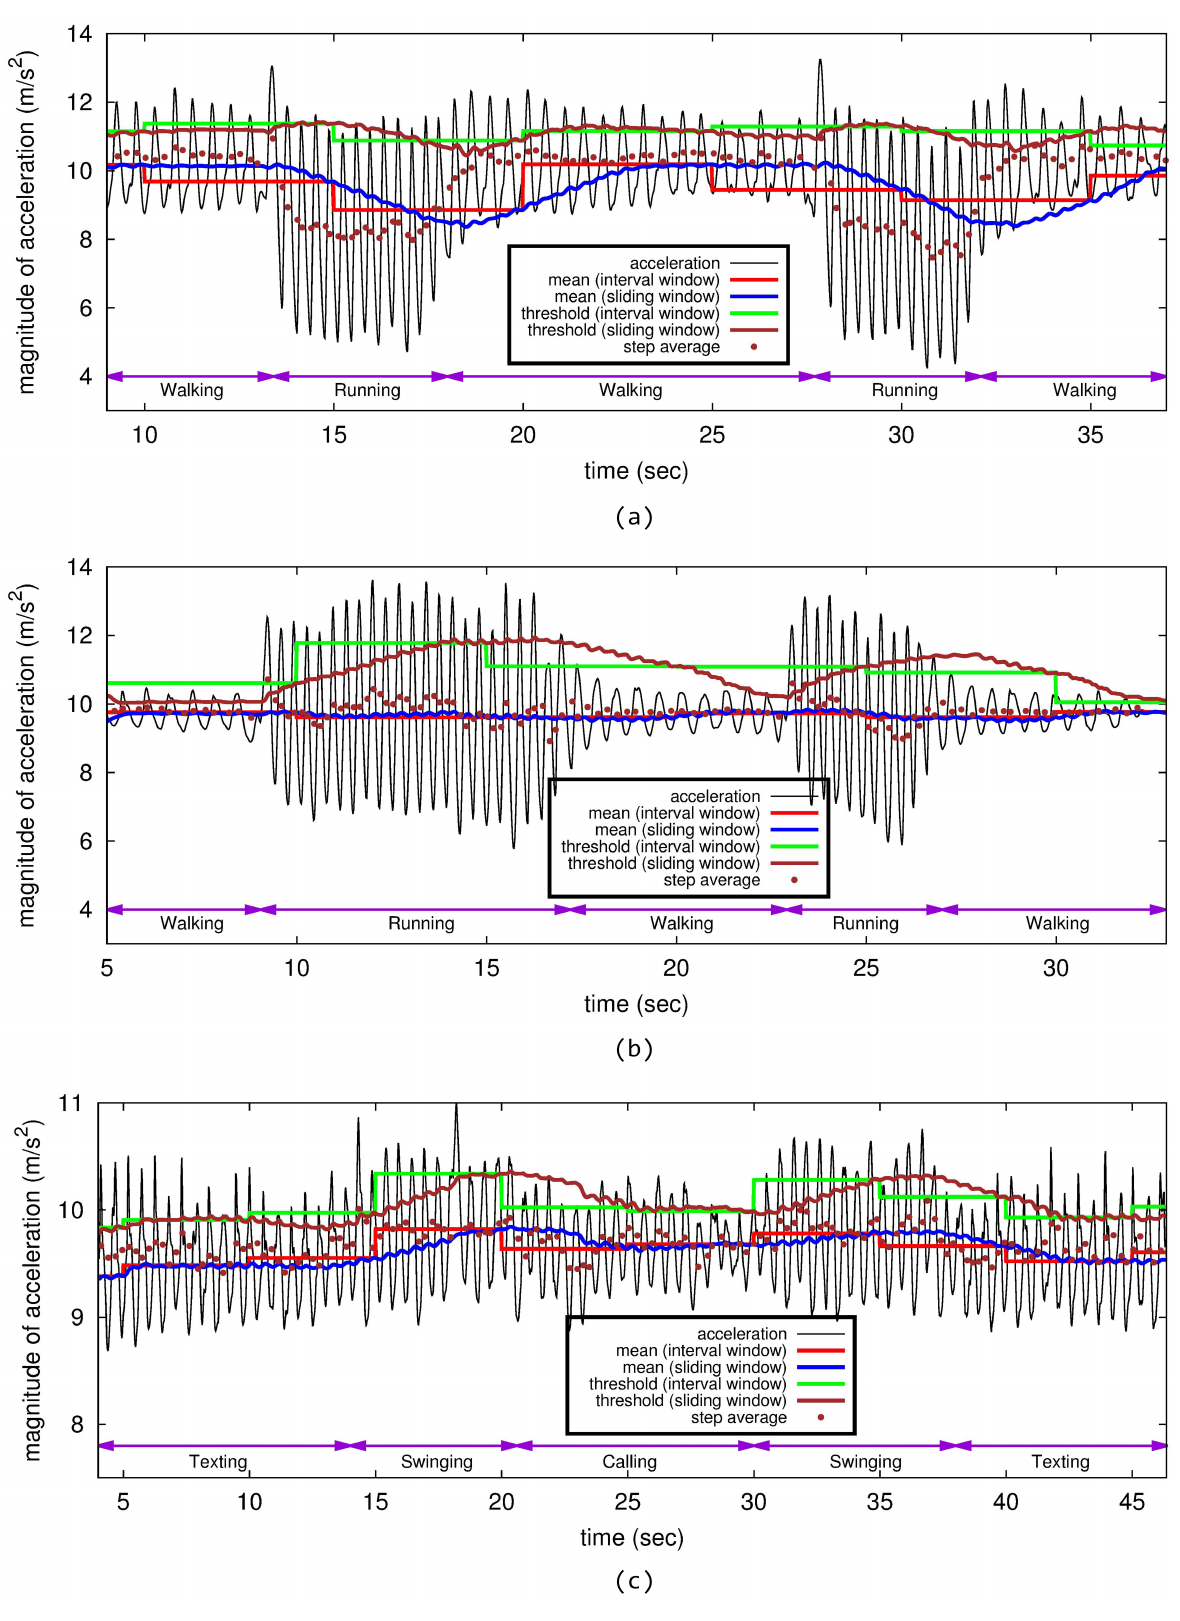
Figure 1. Time-varying statistics of the magnitude of acceleration during transitions of step mode or device pose. ( a ) Missing peaks during step mode transitions: walking to running; ( b ) missing peaks during step mode transitions: running to walking; ( c ) missing peaks during device pose transition: